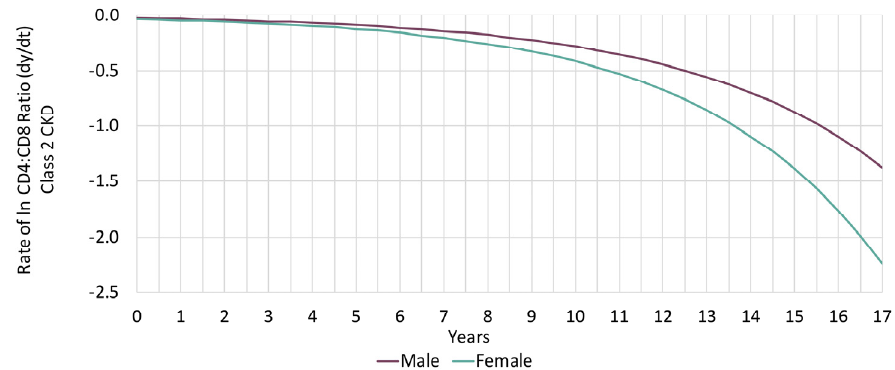
Figure 2. ln ( CD 4 : CD 8 ) trajectory plot per six months among participants who developed chronic Figure 2. 𝑙𝑛(𝐶𝐷4:𝐶𝐷8) trajectory plot per six months among participants who developed chronic kidney disease (CKD) in Class 2 by kidney disease (CKD) in Class 2 by sex.